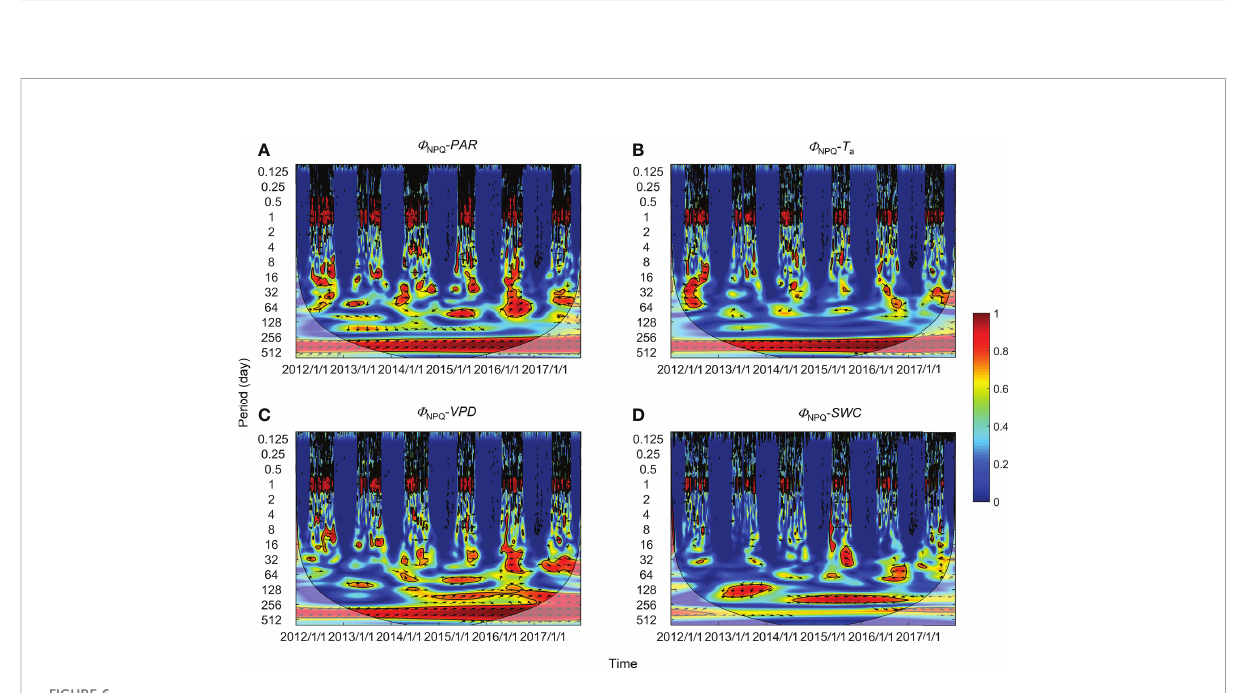
FIGURE 6 Wavelet coherence between non-regulatory thermal dissipation ( F NO ) and (A) photosynthetically active radiation ( PAR ), (B) air temperature ( T a ), (C) vapor pressure de fi cit ( VPD ), and (D) soil water content at a 0.3-m depth ( SWC ). The phase difference is shown by arrows. Arrows pointing upward indicate environmental factors leading F NPQ by 90°, whereas arrows pointing downward indicate environmental factors leading F NPQ by 270°. Arrows pointing left (or right) indicate environmental factors and F NPQ vary in-phase (or anti-phase). Black contour lines represent the 0.05 critical signi fi cance level. The thin arced lines denote the cone of in fl uence (COI) that delimits the region not affected by edge